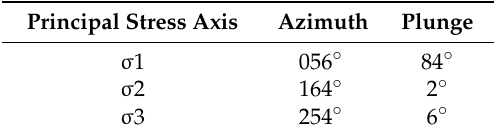
Table 2. Calculated principal stress directions from the stress inversion on the epidote data (inversion B).